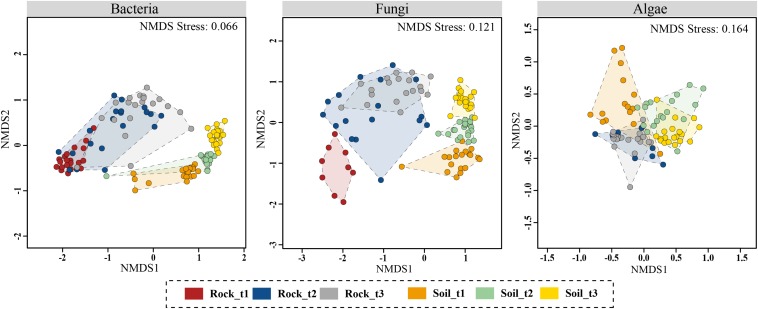
Non-metric multidimensional scaling (NMDS) ordination plots of Bray–Curtis dissimilarities for bacterial, fungal and algal communities across sample categories (i.e., substrate type plus successional stage). Analyses were based on OTU data matrices. Results using ASV data are Supplementary Figure S12.